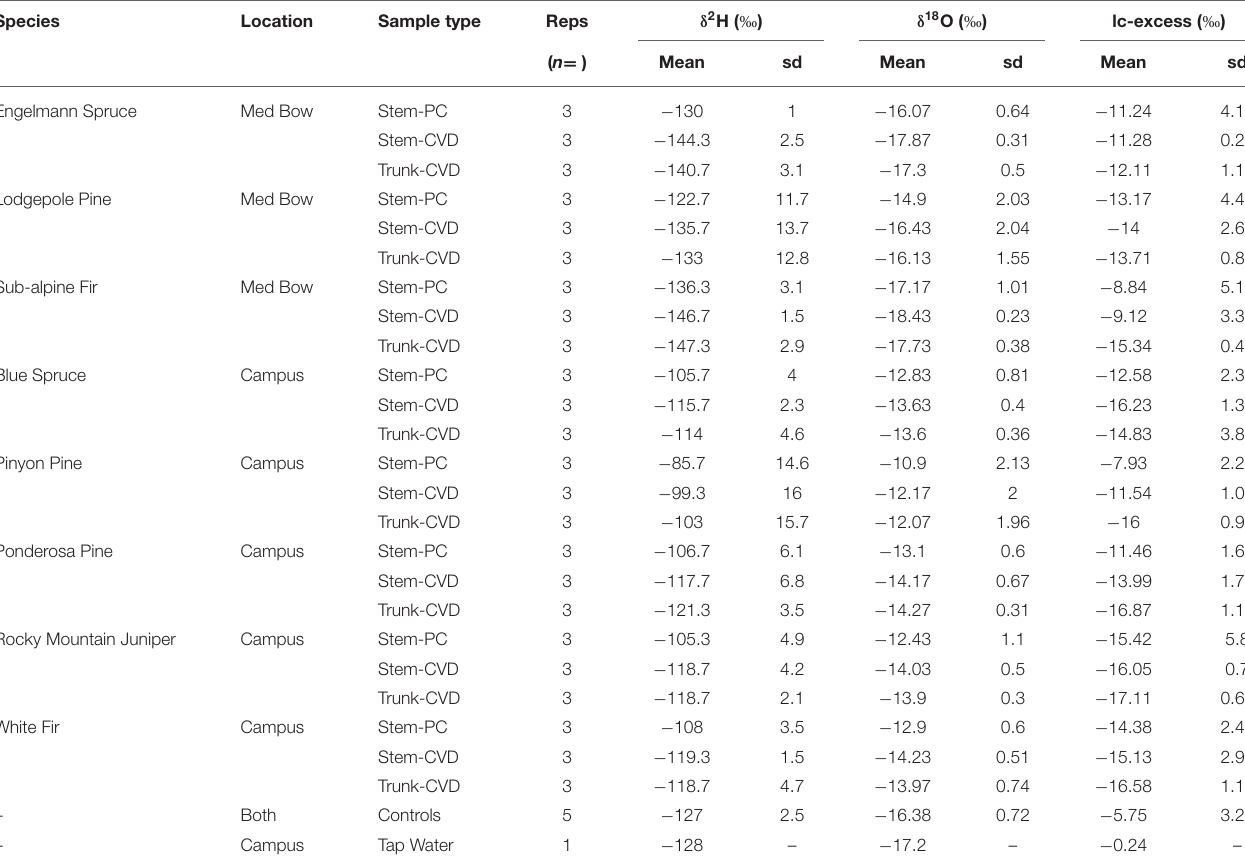
TABLE 1 | Summary table of mean δ 2 H, δ 18 O, and lc-excess values and standard deviation (sd) of δ 2 H, δ 18 O, and lc-excess values separated by sample type and species.